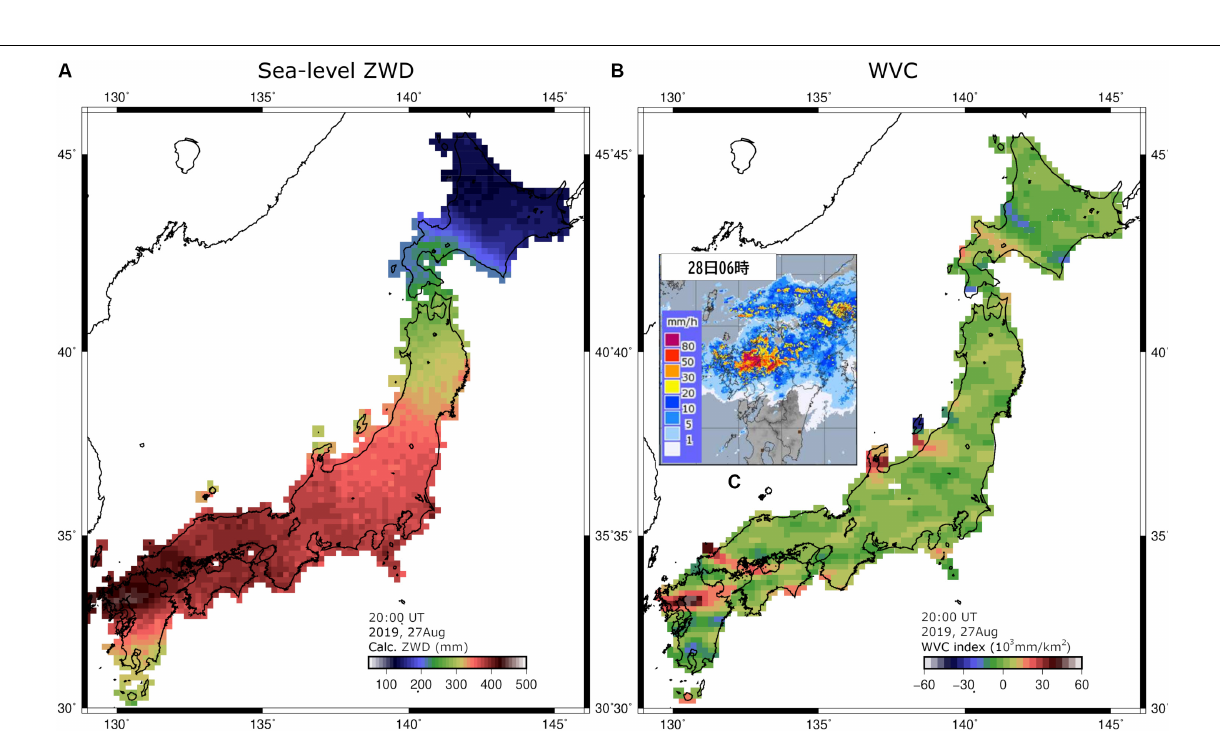
Frontiers in Earth Science |